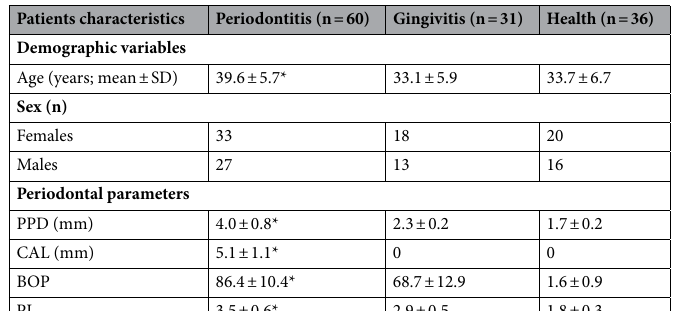
Table 1. Demographics and full-mouth clinical parameters of the study groups. All data are given in terms of mean ± SD. PPD: Probing Pocket Depth. CAL Clinical Attachment Loss. BOP Bleeding On Probing. PI Plaque Index. * p < 0.05: significantly higher than the gingitivis and health groups.